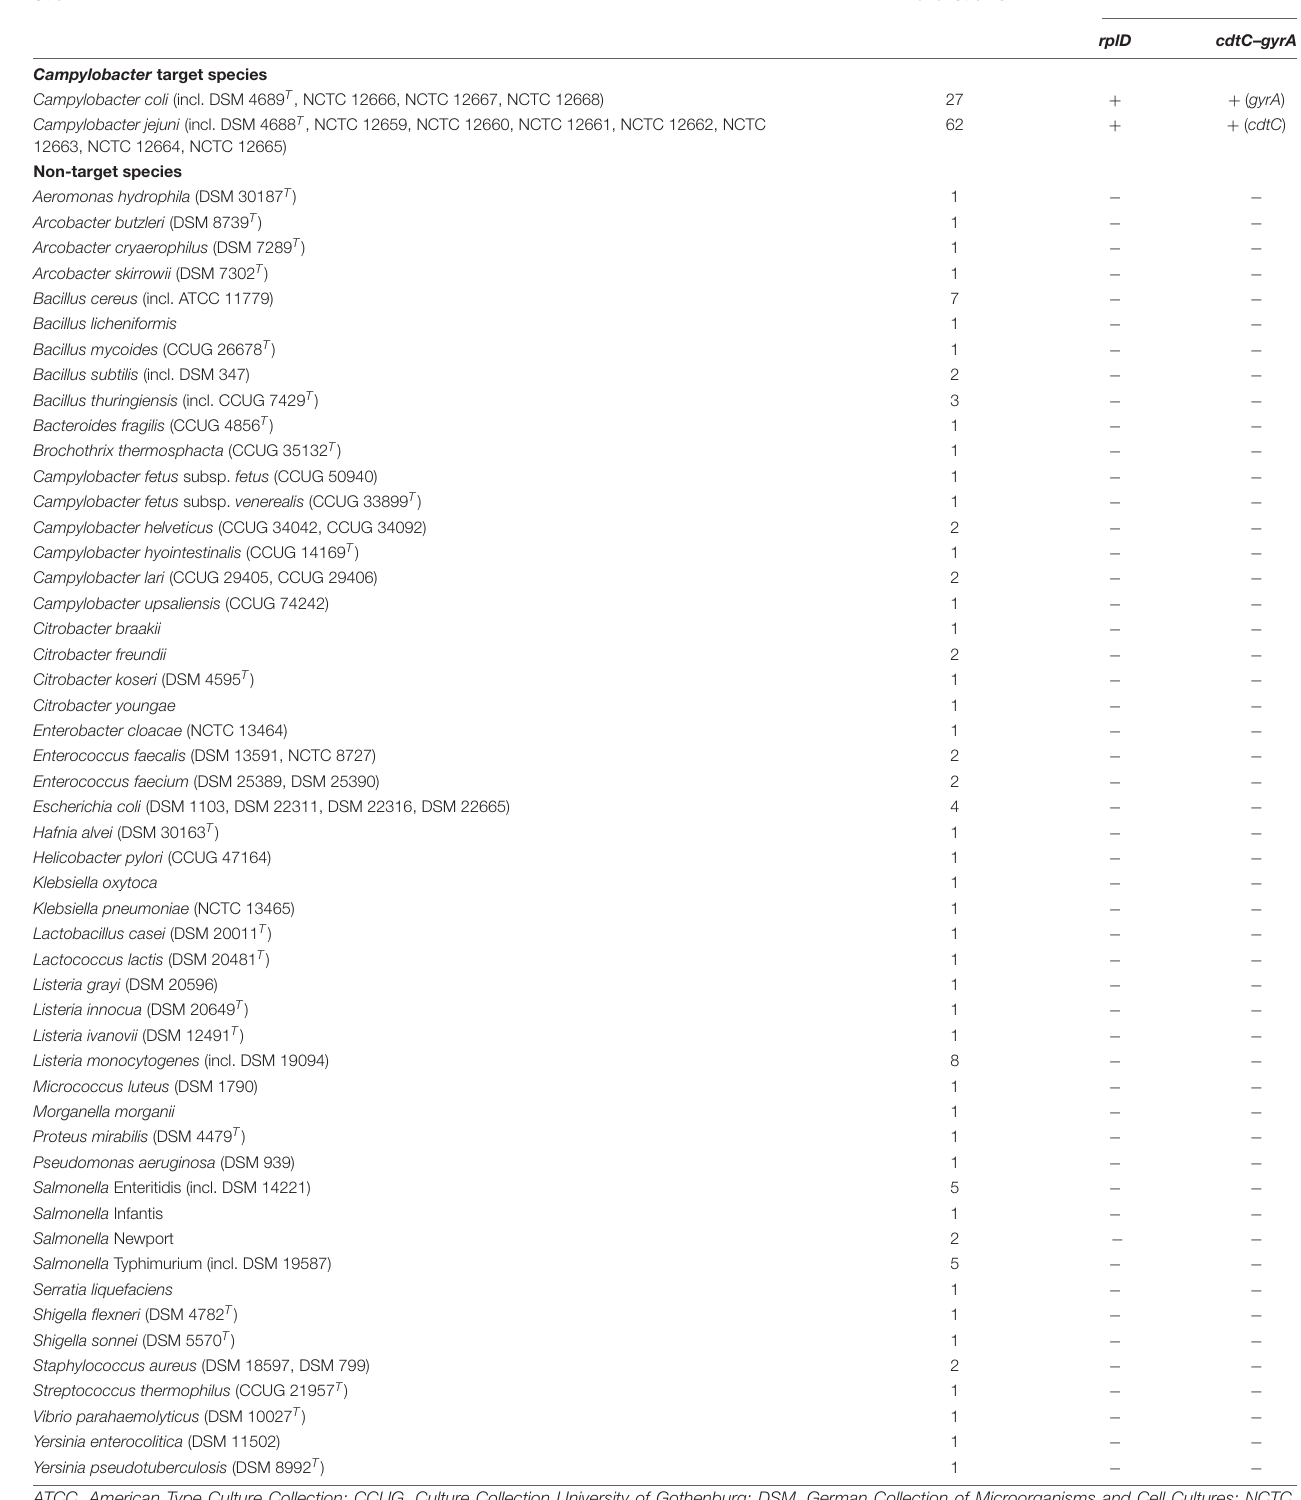
TABLE 2 | Analytical specificity of the rplD and cdtC – gyrA LAMP assays against target and non-target bacterial strains. Strain No. of strains